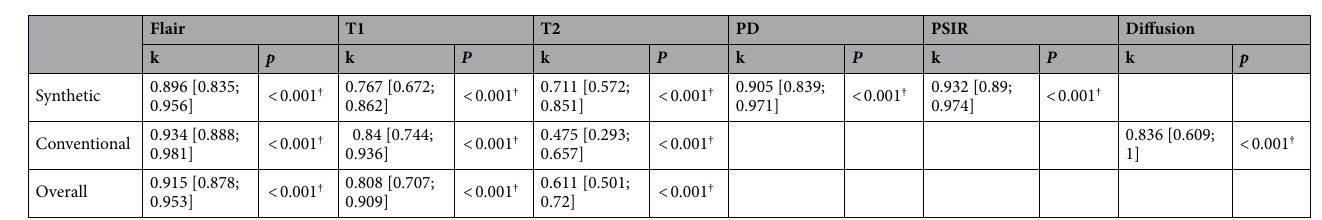
Table 1. Inter-rater reliability (PJ vs JA). PJ, experienced neuroradiologist; JA, neuroradiologist trainee; Cohen’s κ coefficient—[95% CI]. † p <